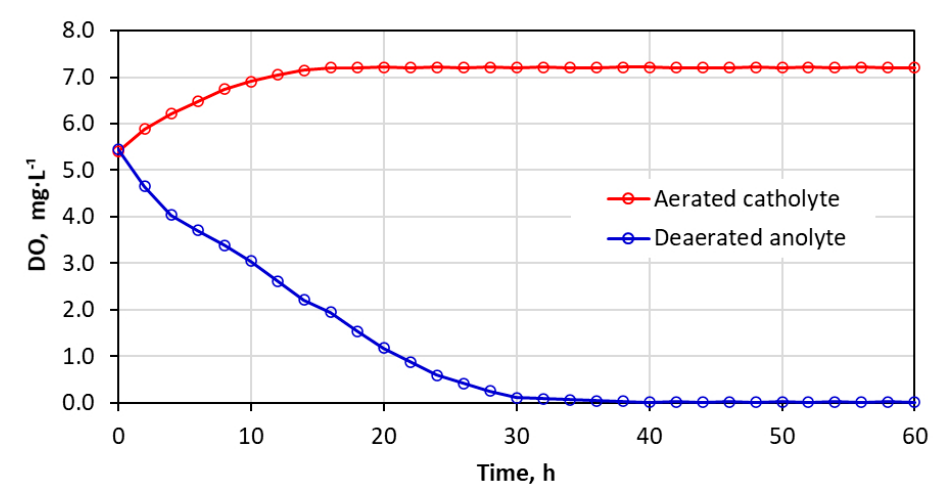
Figure 2. Change of dissolved oxygen (DO) concentration over time in aerated by air catholyte and deaerated by nitrogen gas anolyte-model wastewater.